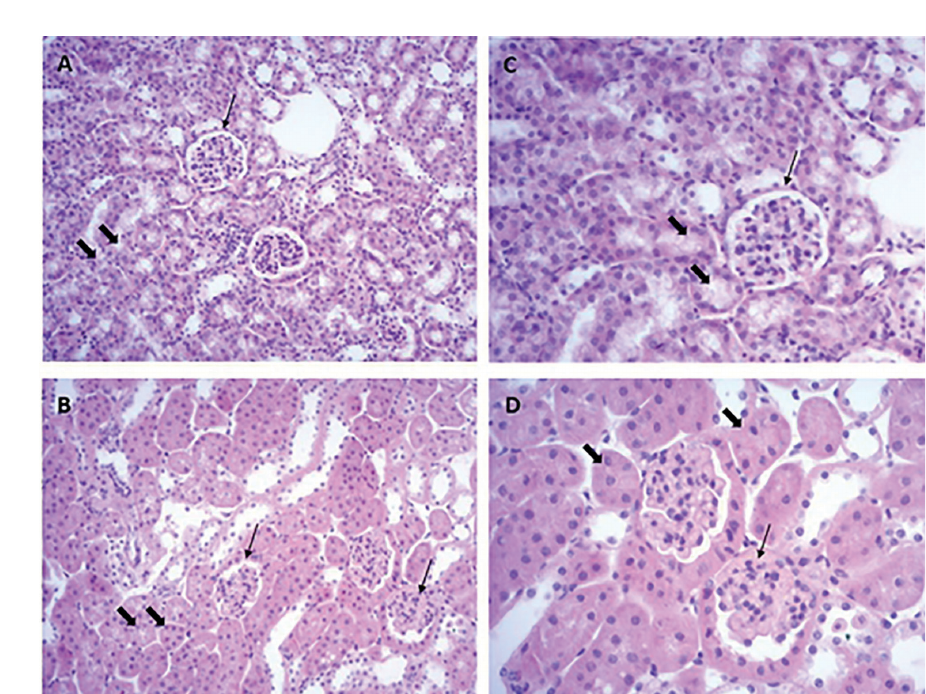
FIGURE 2 - Photomicrography of kidney transversal section, stained with HE (A,B: 200X; C,D 400X). The thin arrows correspond to the renal corpuscle and the thick arrows indicate the convoluted tubules. A and C, Control group and B and D, group under